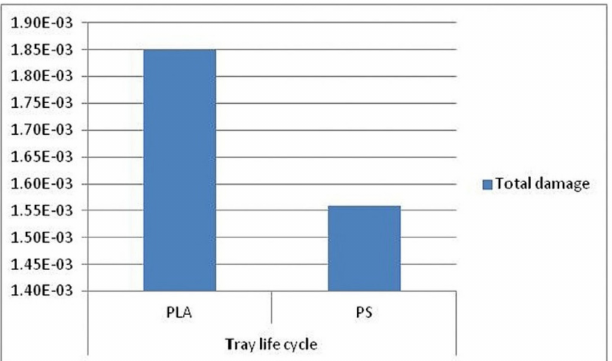
Figure 6. A comparison of the (total) damages associated with the life cycles of PLA and polystyrene (PS) trays. Values are expressed as pt.kg tray − 1 . Reprinted from [16], © 2020 with permission from Elsevier.